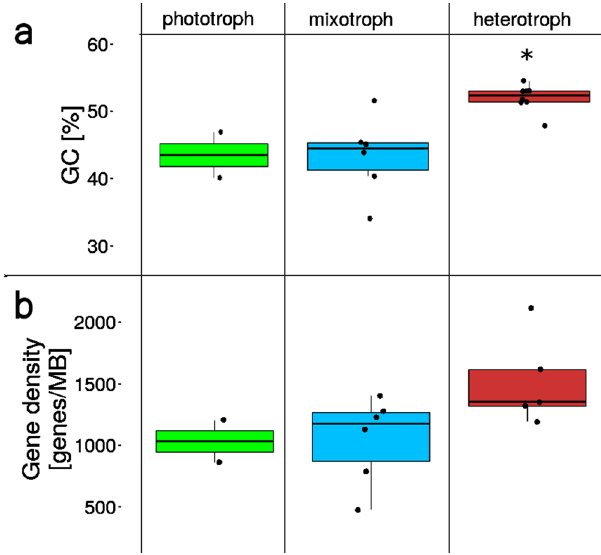
Fig. 4 GC content and gene density in relation to nutritional mode. a The GC content depends on the nutritional mode ( p < 0.001). The GC content of the heterotrophic group is signi fi cantly different from the mixotrophic and phototrophic groups (marked with an asterisk). Error bars represent standard deviations. b There is no signi fi cant correlation between trophic mode and gene density. Phototroph: green, n = 2; mixotroph: blue, n = 6; heterotroph: red, n = 8 biologically independent